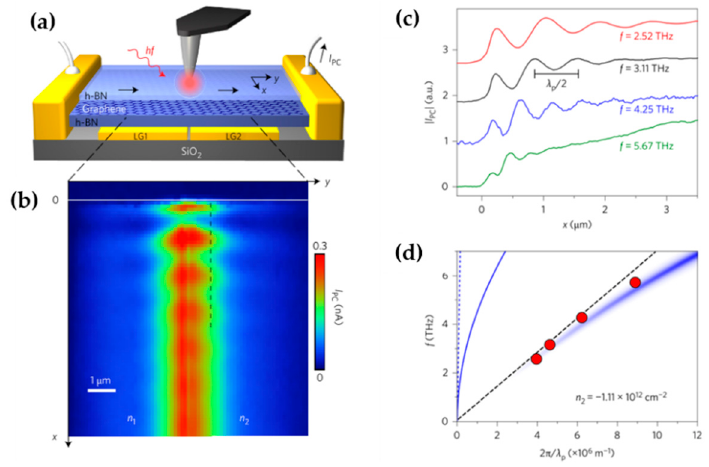
Figure 10. THz photocurrent nanoscopy: ( a ) Illustration of the experimental setup. LG1 and LG2 represent the split gates of gold used to control the carrier concentration in the graphene. ( b ) Photocurrent image recorded for 2.52 THz and with n 1 = 0.77 × 1012 cm − 2 and n 2 = − 0.71 × 1012 cm − 2 set by LG1 and LG2, respectively. ( c ) Near-field photocurrent profiles for different frequencies recorded along the dashed line in ( b , d ) Experimental (red dots) and theoretical dispersion relations in the heterostructure (blue color plot), free-standing graphene (blue solid line), light line in free space (blue dashed line), and acoustic plasmons (dashed black curve). Reprinted with permission from